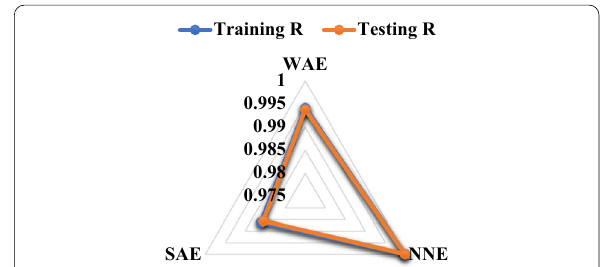
Fig. 9 Radar surface performance of the ensemble techniques in both the training and testing stages